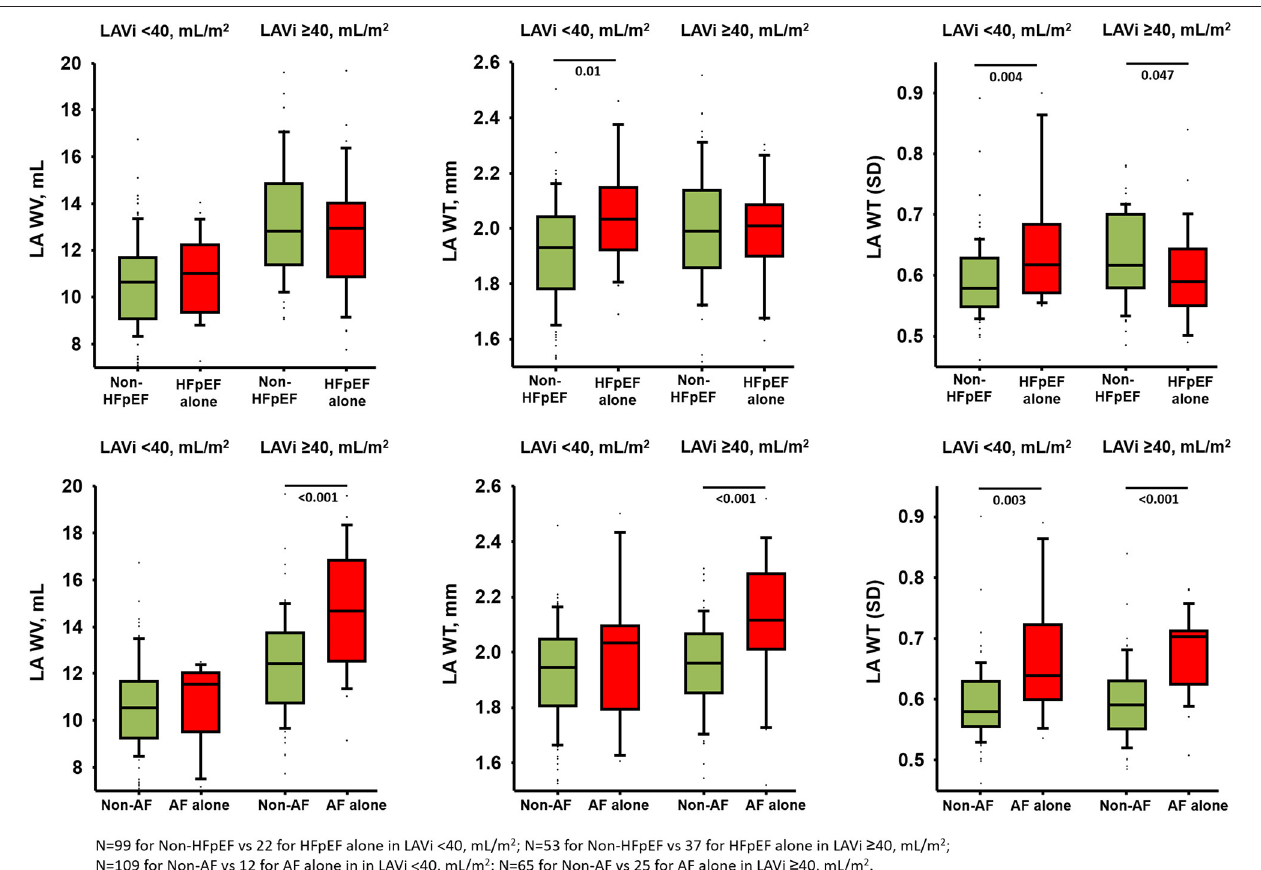
FIGURE 3 | Comparisons of LA wall indices in isolated HFpEF and AF in smaller and larger indexed LA volume after excluding patients with both HFpEF and AF (total n = 211).